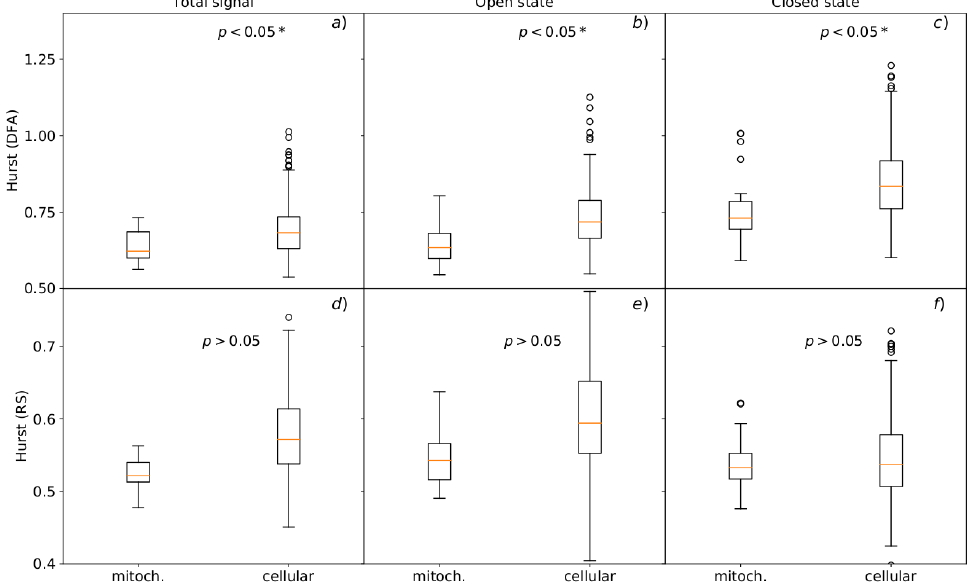
Figure 5. The Hurst exponents obtained by the standard R/S and the generalized DFA methods which describe dwell-time series of BK channel states for the channels located in mitochondrial and cellular membrane patches. The upper panels ( a – c ) present the results obtained at membrane hyperpolarization; the lower graphs ( d – f ) show the results corresponding to membrane depolarization. The boxes extend from the lower to upper quartile values. The line inside each box characterizes the median value and the whiskers represent the range of the data. Outlier points are those that exceed the ends of the